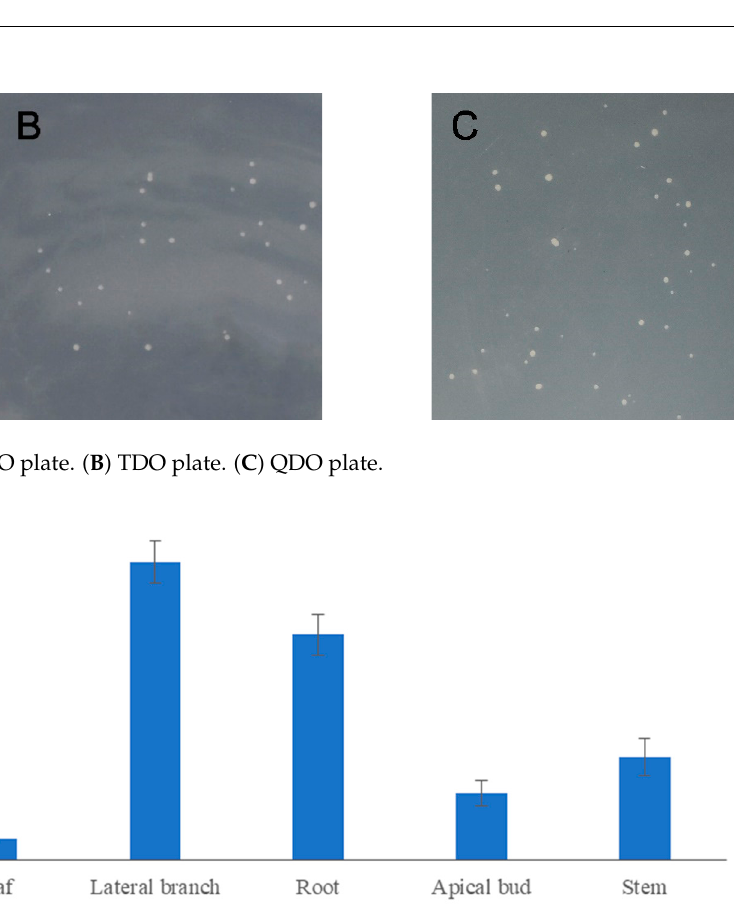
8 of 15 Figure 4. Target protein. ( A ) Fluorescence channel. ( B ) Marker fluorescence channel. ( C ) Chloroplast fluorescence channel. ( D ) Bright field. ( E ) Superimposed plot. 3.4. Analysis of the Transcriptional Activity of CmRAX2 As shown in Figure 5, the bait plasmid PGBKT7- CmRAX2 and prey unloaded PGADT7 co-transformed the Y2H Gold Competent Cell, which was able to grow after being coated on a DDO plate. This indicated that the recombinant bait plasmid was suc- cessfully transferred into host bacteria and had no toxicity to host bacteria. The bait pro-